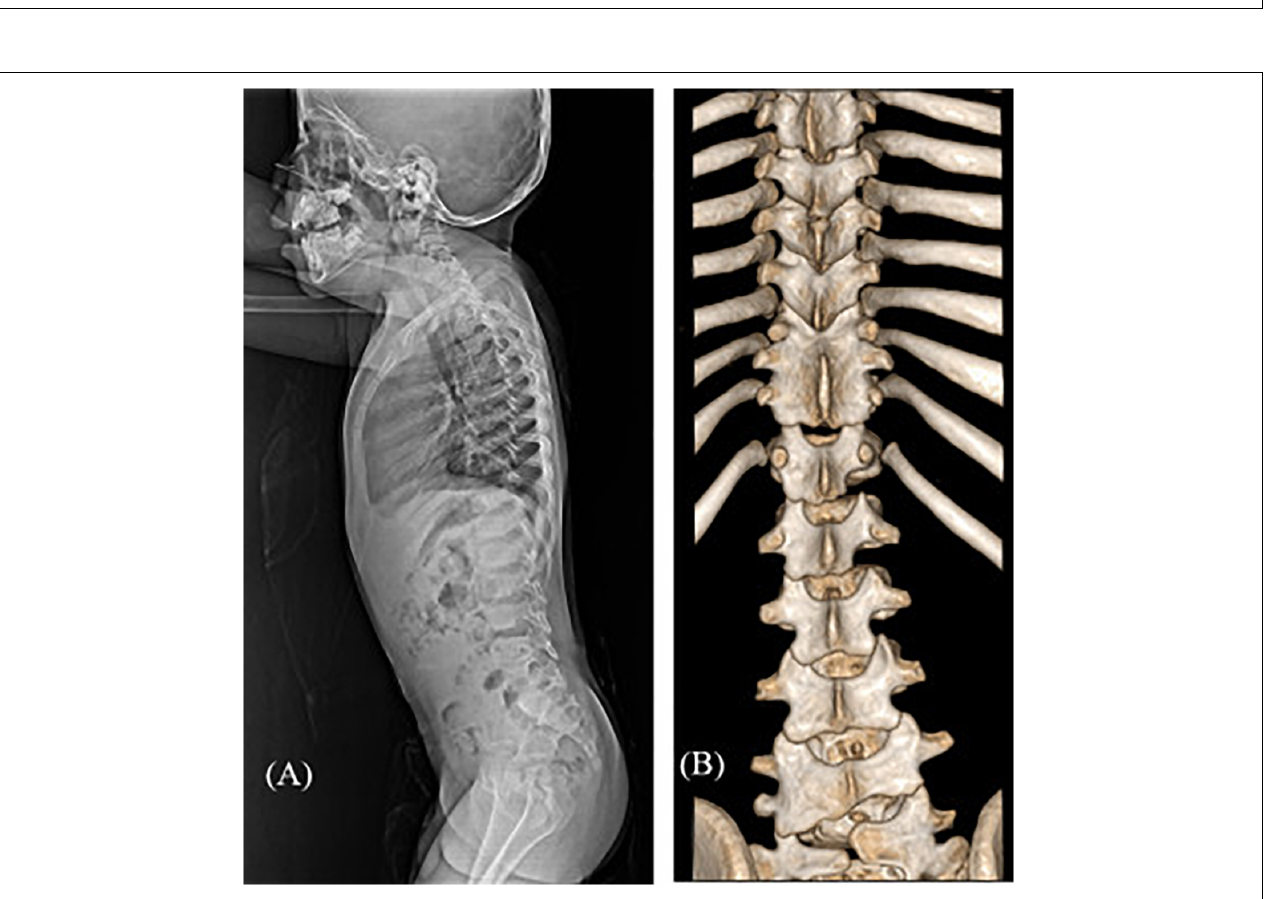
FIGURE 3 | Radiographic images of case #16 with spondylocarpotarsal fusion syndrome 1A. (A) Lateral spine X-ray showing mildly narrowed disk spaces (B) 3D reconstruction CT scan showing fusion of T9-10-11 bilateral facet joints and spinous processes and L4-5 left facet joints.